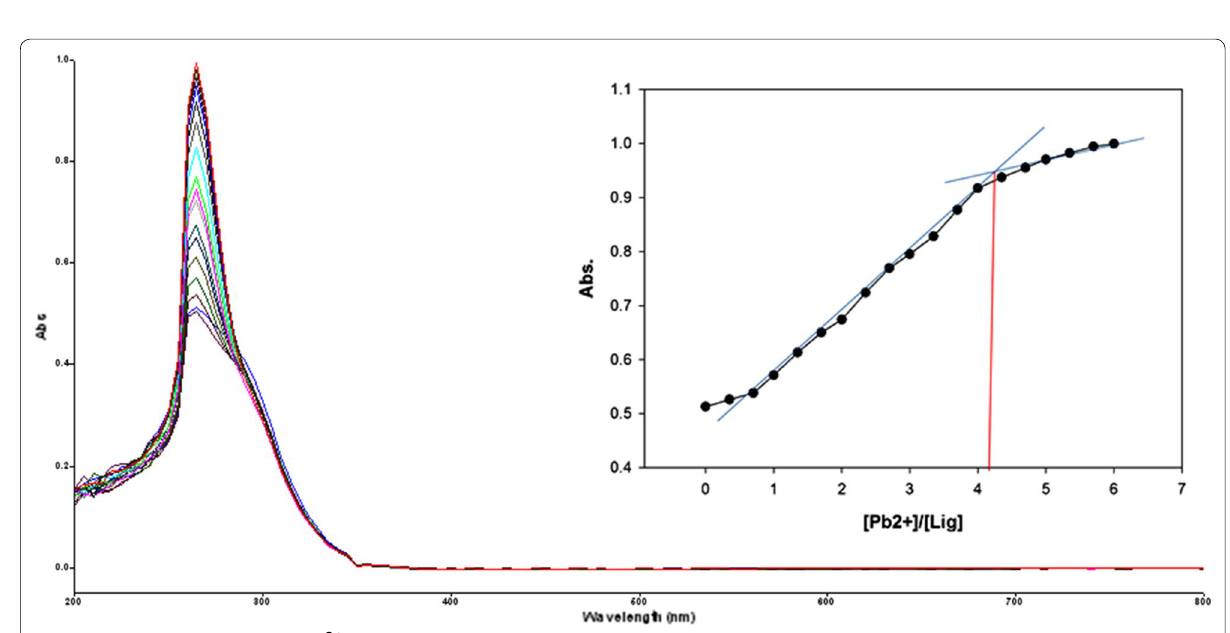
Fig. 12 Titration of isomer 1A vs Pb 2 + ( Inset Binding behavior